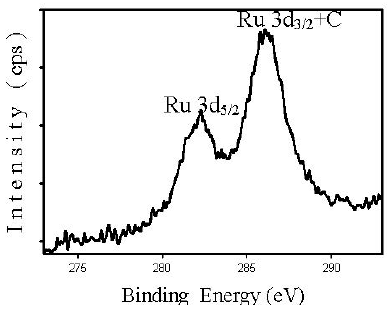
Figure 6. Ru 3d XPS spectra of the Re-Ru@SiO 2 nanoparticles.